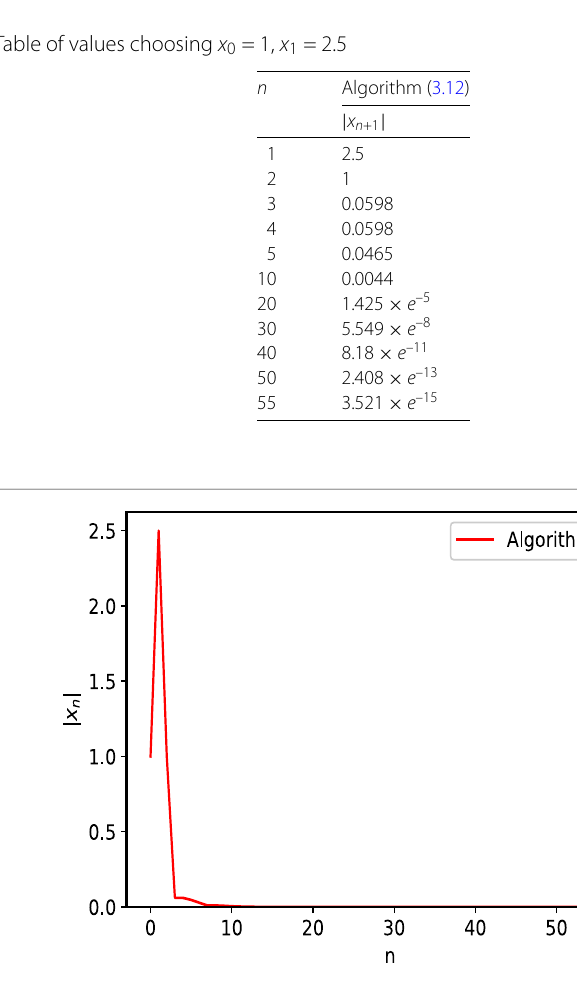
Figure 3 Graph of the first 55 iterates of Algorithm (3.12) choosing x 0 = 1, x 1 =